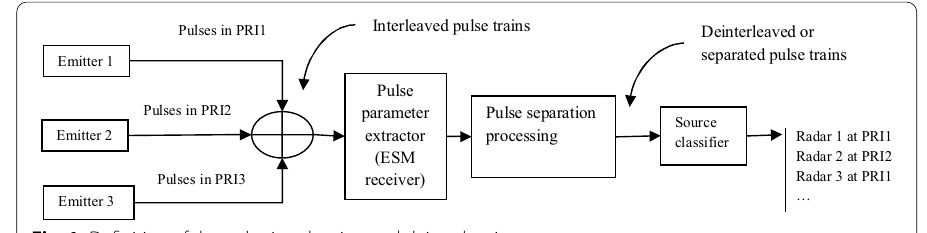
Fig. 1 Definition of the pulse interleaving and